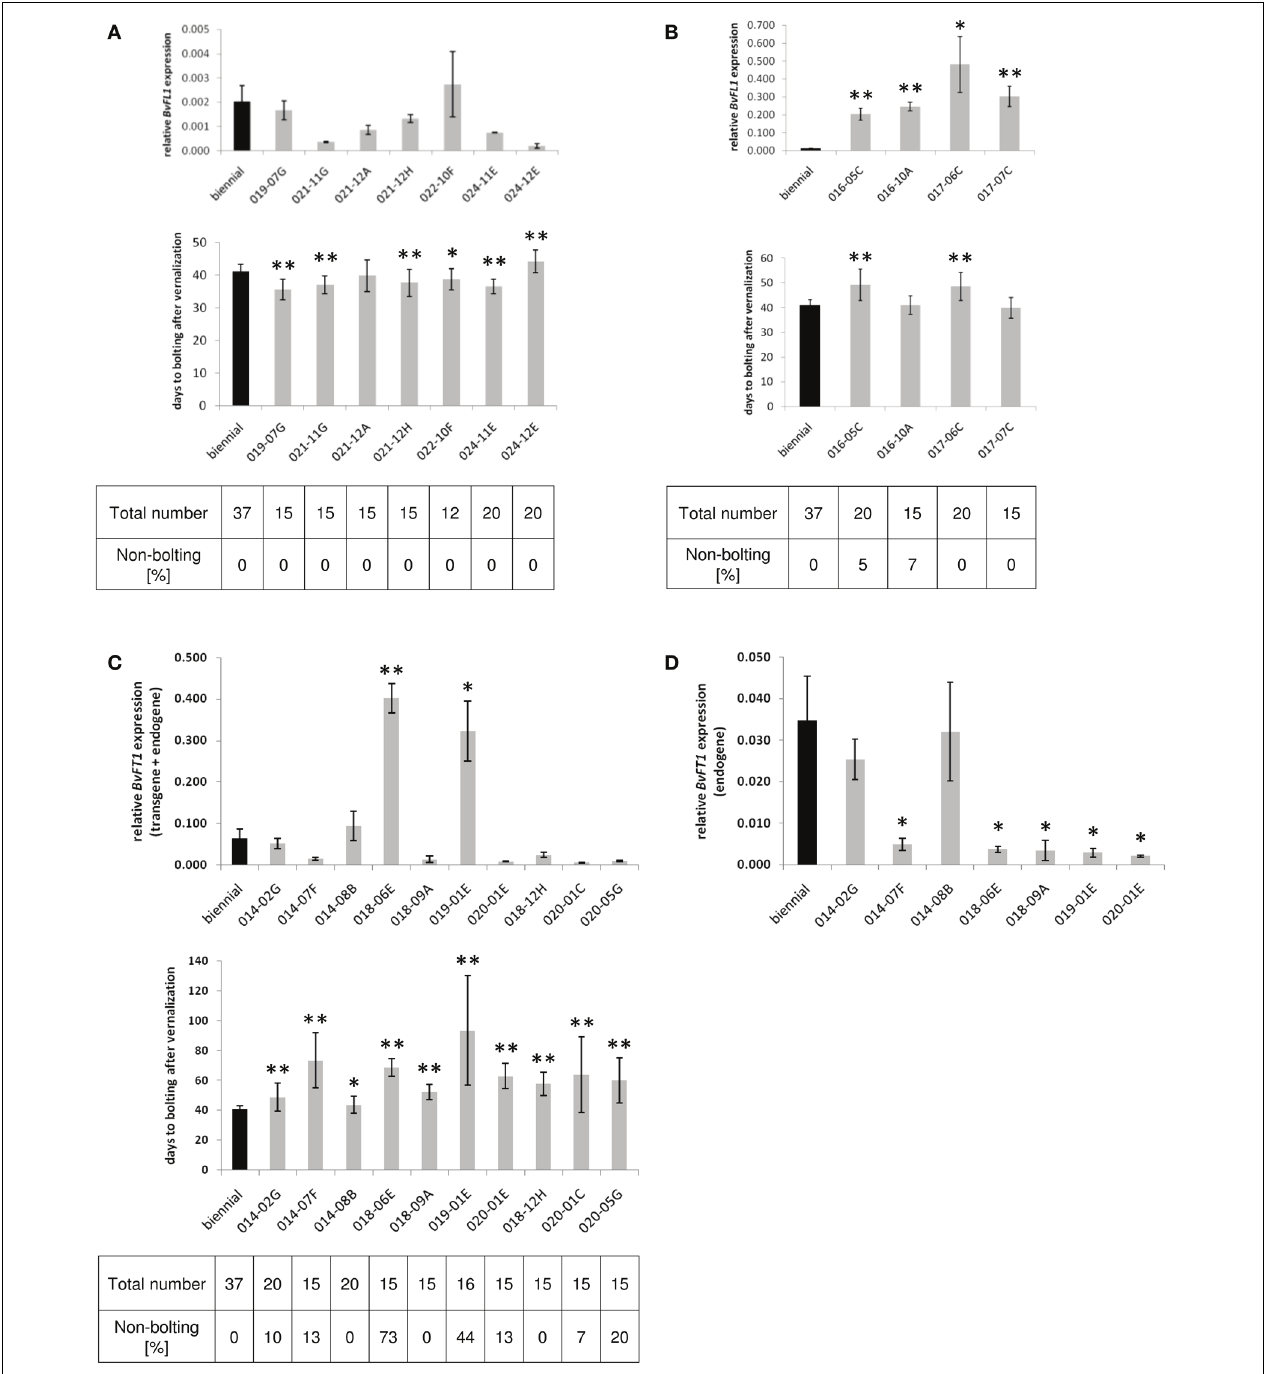
FIGURE 1 | Gene expression and bolting time phenotypes in BvFL1 RNAi (A), BvFL1 over-expression (B), and BvFT1-BvFT2 RNAi transformants (C,D). Leaf samples of non-vernalized plants derived from independent sugar beet transformation events and the non-transgenic biennial control genotype were taken under long-day conditions at Zeitgeber time (ZT) 6-8. For each transgenic event, three clones were analyzed as biological replicates, and each RT-qPCR reaction was run in triplicate. Gene expression was normalized using the house-keeping gene BvGAPDH and the 2 − (cid:2)(cid:2) CT method (Schmittgen and Livak, 2008). Error bars represent mean ± SE of the mean. Expression of BvFT1 in BvFT1-BvFT2 RNAi plants was determined with